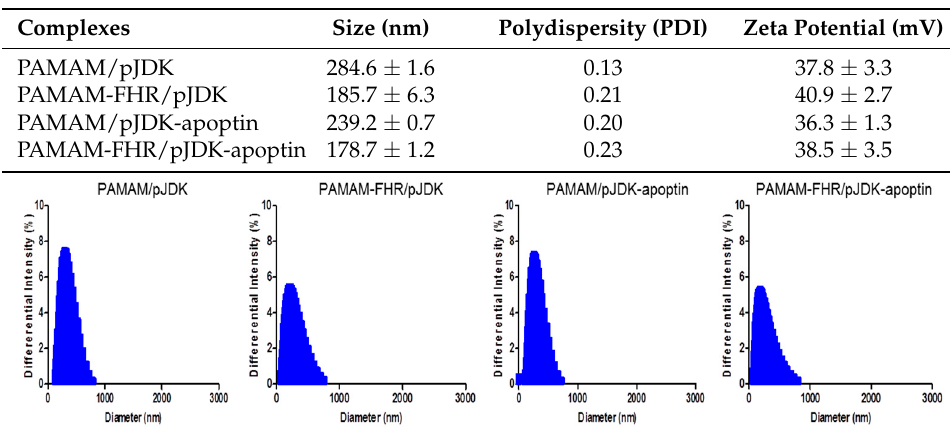
Table 1. The characteristics of mean diameter, polydispersity, and zeta potential values of polymer/pJDK or pJDK-apoptin complexes.